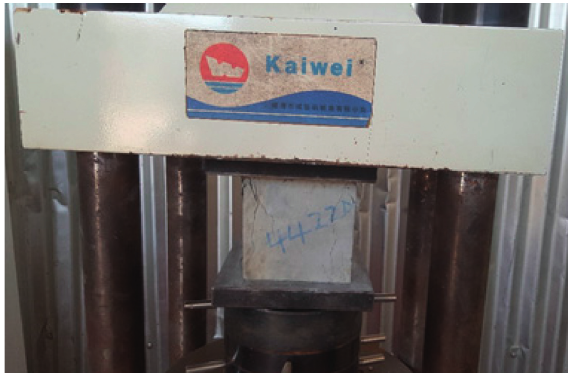
Figure 4: Compressive strength test